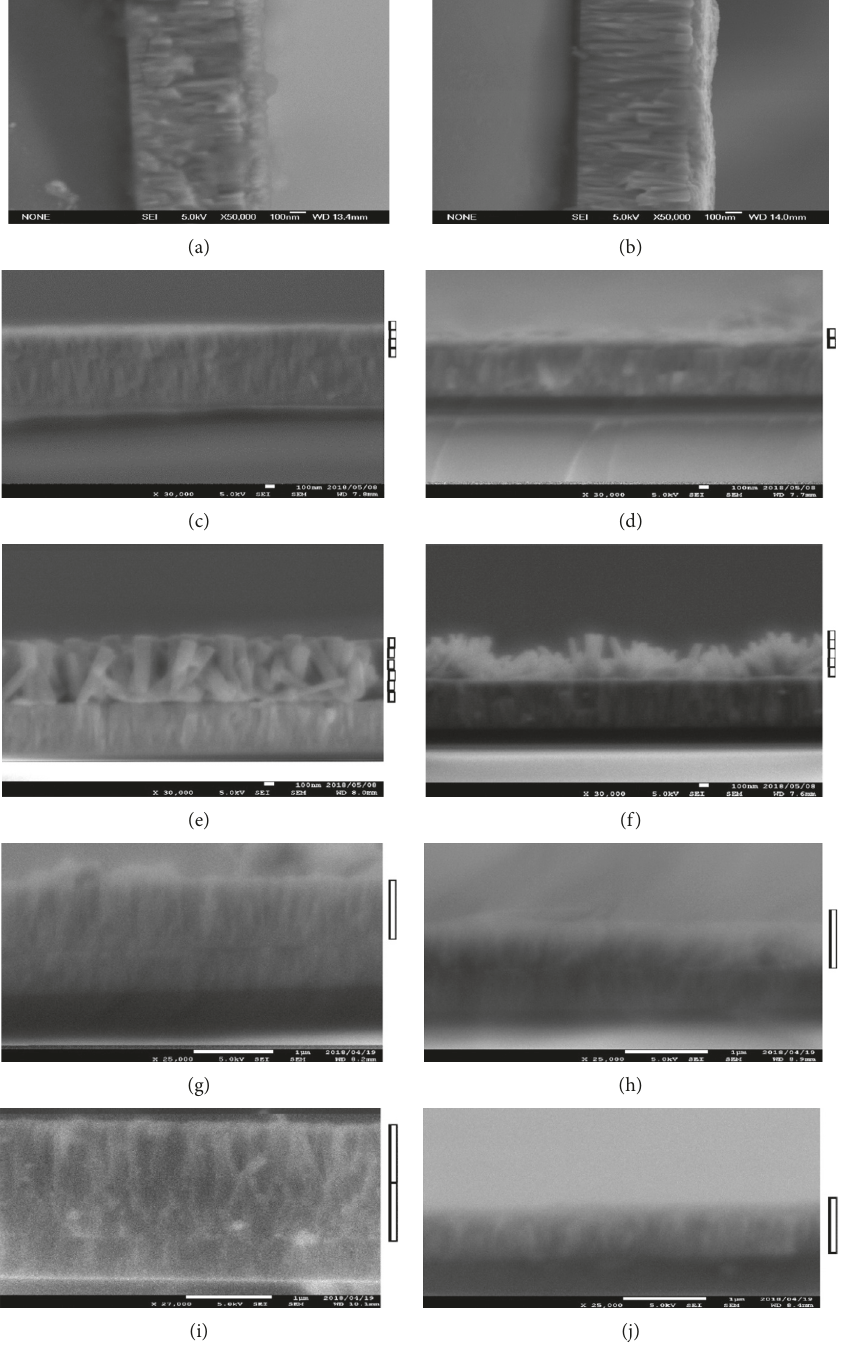
Figure 3: SEM images (cross section view) of ZnO NRs from both zinc sources, i.e., ZA (left column) and ZN (right column), grown using the waterbath method at t � 0, 15, 60, 90, and 120 minutes. (a) t � 0 minutes, ZA. (b) t � 0 minutes, ZN. (c) t � 15 minutes, ZA. (d) t � 15 minutes, ZN. (e) t � 60 minutes, ZA. (f) t � 60 minutes, ZN. (g) t � 90 minutes, ZA. (h) t � 90 minutes, ZN. (i) t � 120 minutes, ZA. (j) t � 120 minutes,